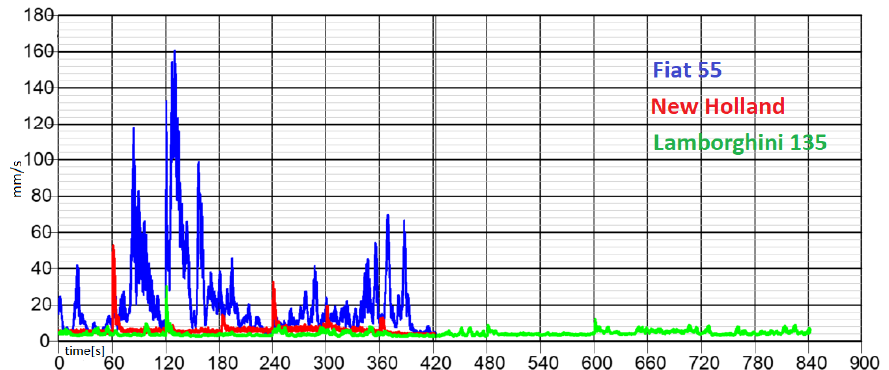
Figure 5. Comparison of time history for all tractors at 1000 rpm.